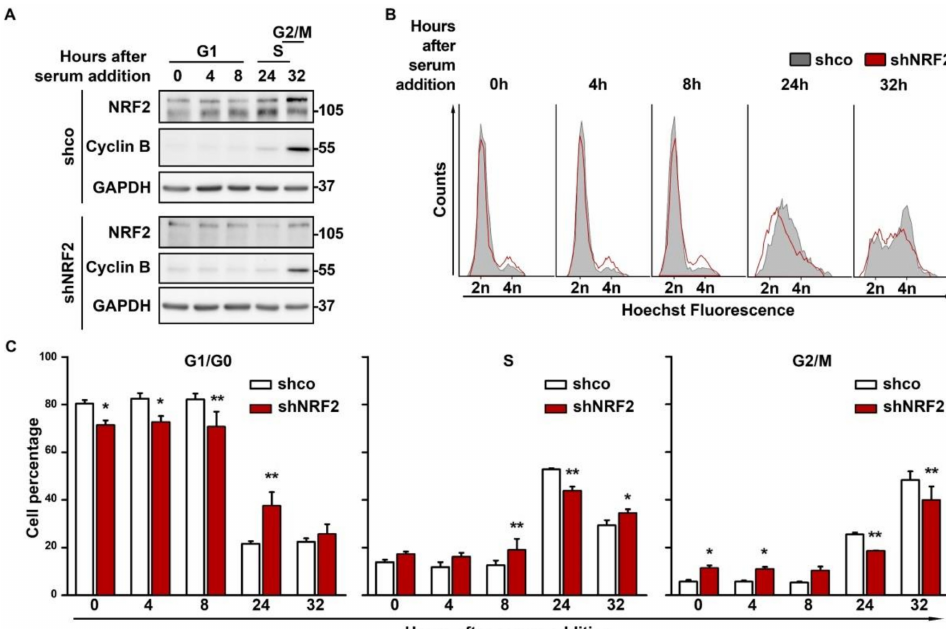
Figure 3. NRF2 absence reduces proliferation rate through an increase in G1 duration. U–373 MG cells were transduced with lentiviral vectors containing control (shco) or shNRF2–1 (shNRF2). Cells were then serum–deprived for 64 h for G1/G0 synchronization and then replated in serum–containing medium for cell cycle release. ( A ) Representative immunoblots of NRF2, Cyclin B, and GAPDH as a loading control; ( B ) Changes in cell cycle distribution between G1/G0, S, and G2/M phases after G1/G0 synchronization were determined by Hoechst staining (a.u., arbitrary units of fluorescence emission). A representative sample of 10,000 cells is shown for each condition; ( C ) Quantification of cells in G1/G0, S, and G2/M phases in Hoechst–stained cells. Data are presented as mean ± S.D. ** p ≤ 0.01; * p ≤ 0.05 according to a two–way ANOVA test ( n =